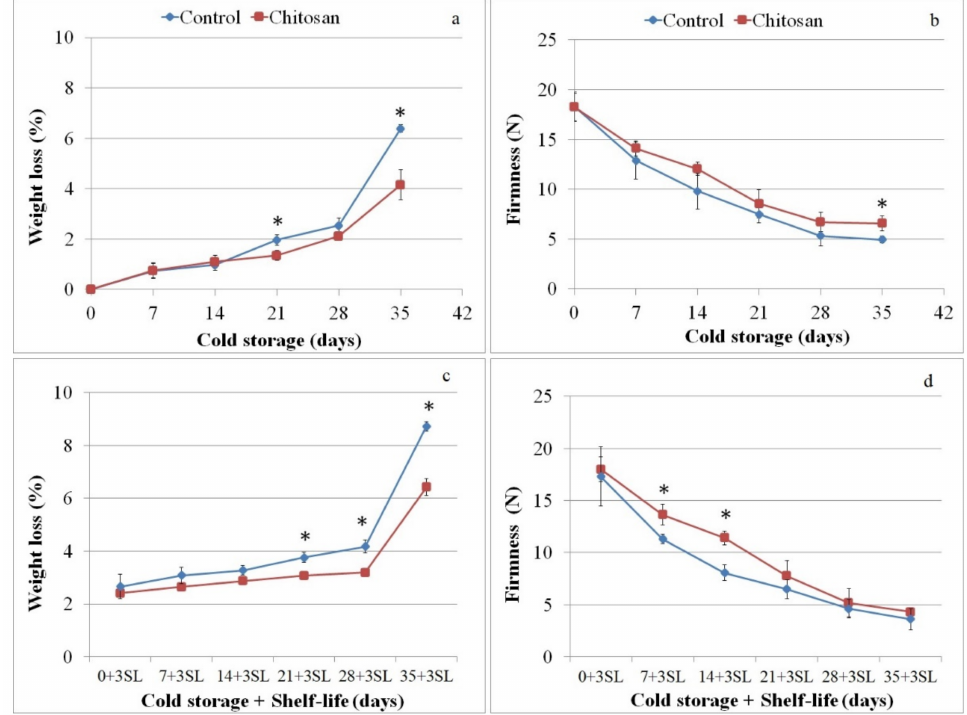
Figure 1. Weight loss (%) and firmness (N) at harvest (0) and after 7, 14, 21, 28 and 35 days of cold storage ( a , b ) followed by 3 days of shelf life ( c , d ) for chitosan-coated (Chitosan) and uncoated fruit (Control). One asterisk (*) indicates p value smaller than 0.05 ( p < 0.05). Firmness values decreased under the cold storage conditions (Figure 1b) and after the shelf-life period (Figure 1d). At the end of cold storage conditions, coated fruit retained significant higher firmness compared to untreated ones, while no statistical difference in shelf life was